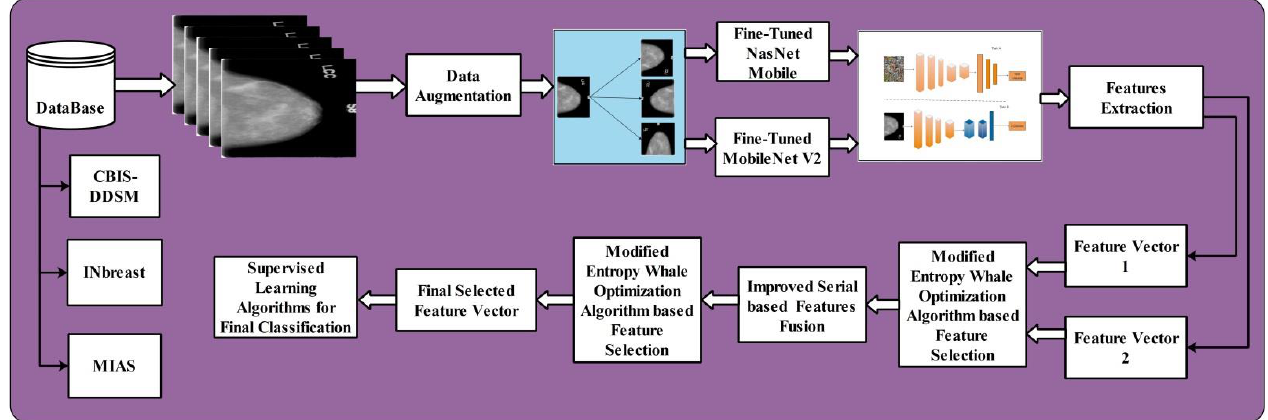
Figure 1. Proposed architecture of classification of breast cancer using deep learning.